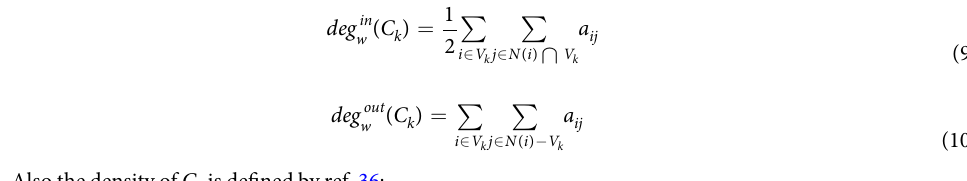
Dataset Algorithm